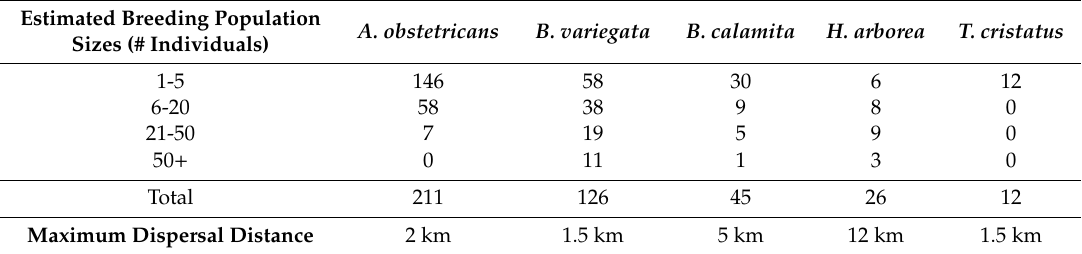
Table 1. Amphibian data indicating the number of breeding ponds for each species and the maximum dispersal distances used. Population sizes were classified into four size categories per